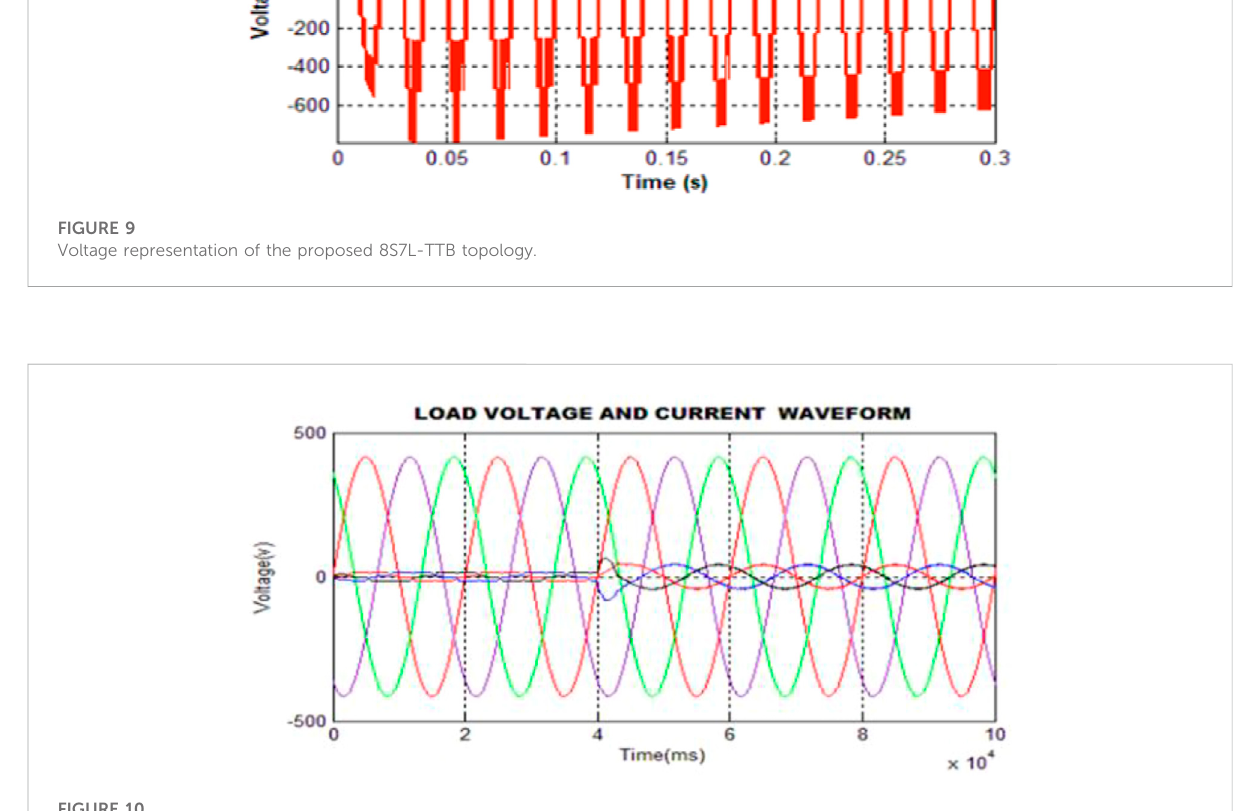
FIGURE 10 Representation of load voltage and load current.